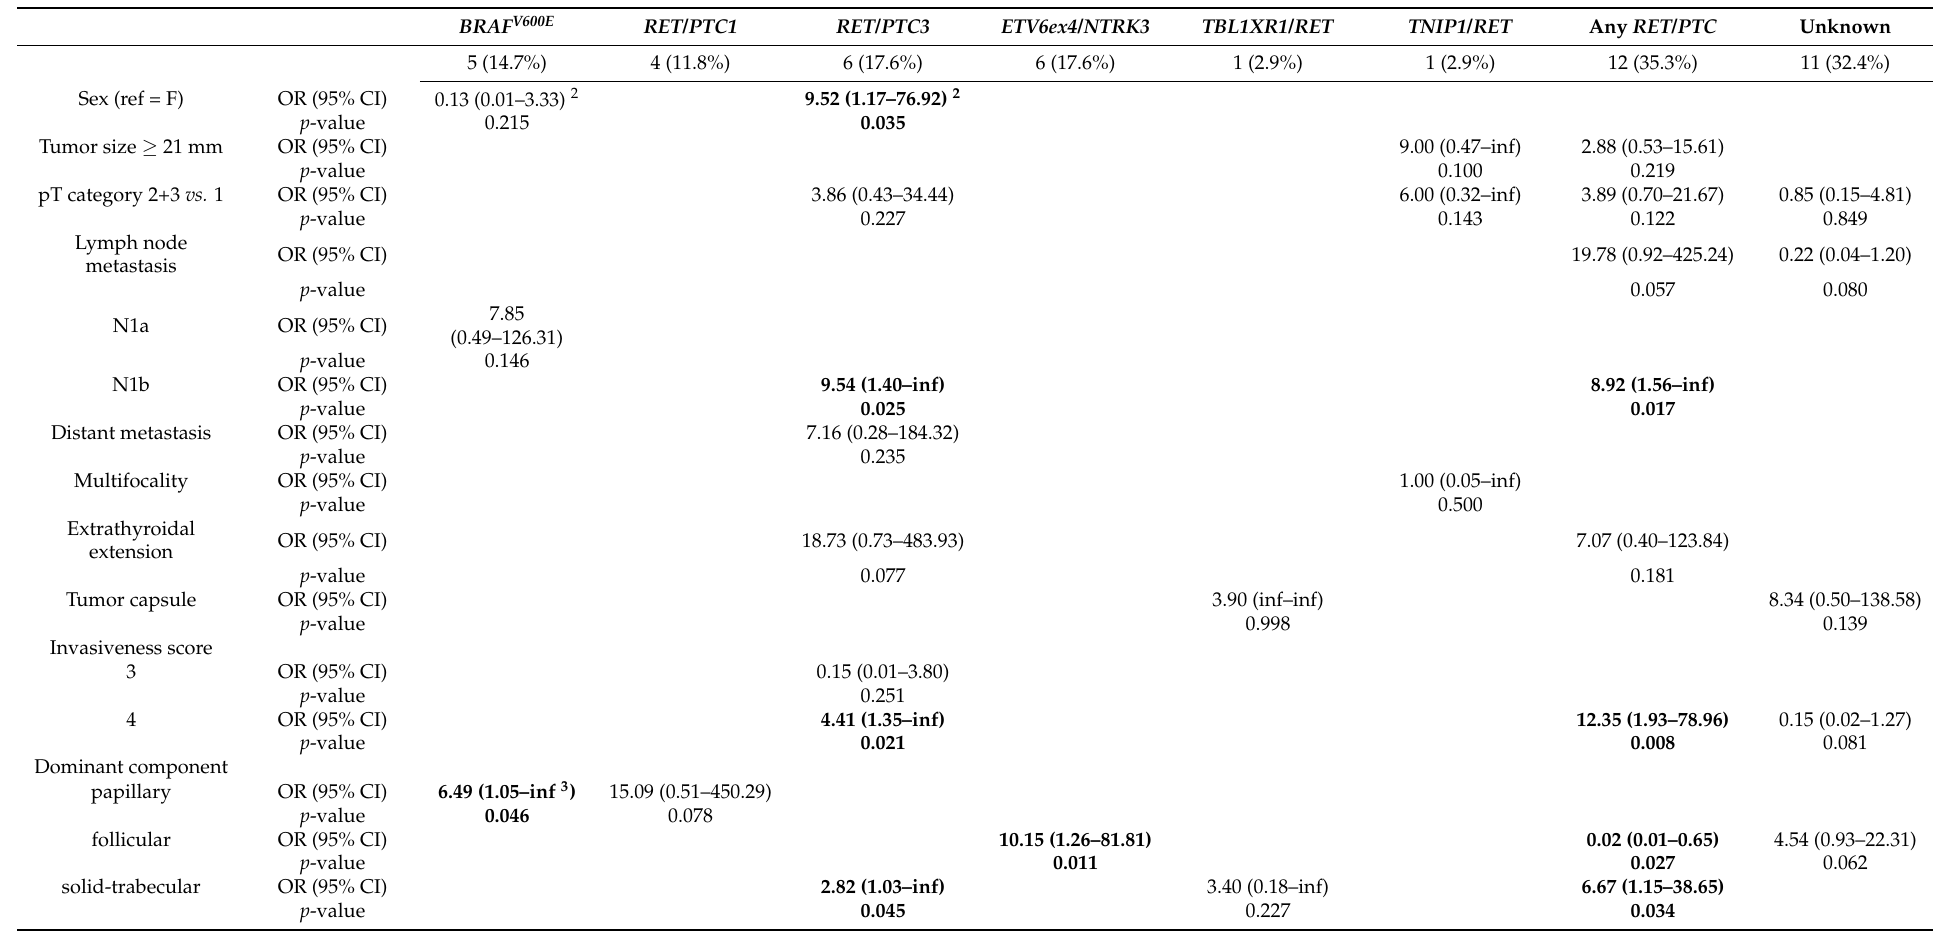
Table 1. Association of mutational status with clinicopathological features in sporadic childhood PTC 1